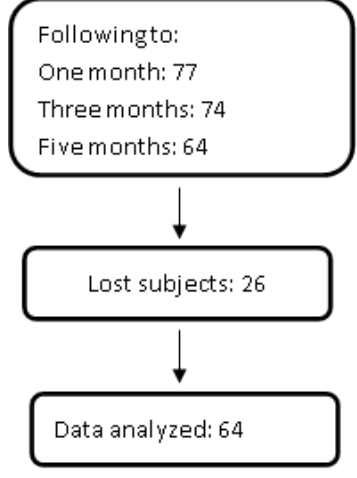
Figure 1. Outline of the study.